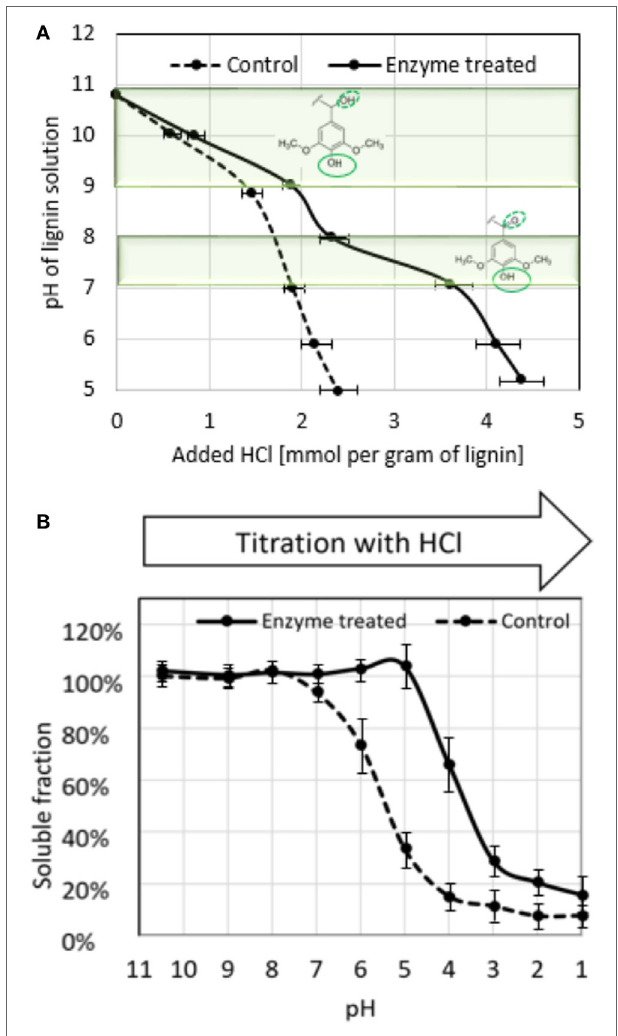
FigUre 3 | Properties of enzyme-treated lignin revealed from acid titration. (a) Acid titration curve of enzyme-treated and control lignin; highlighted areas indicate pH ranges of deprotonation of phenolic hydroxyls (pH 9–11) and phenolic hydroxyls of lignin units with keto group at alpha-carbon (see Discussion), deprotonating hydroxyls in the molecules are outlined with solid line, substituent at alpha-carbon is outlined with dotted line; (B) solubility of enzyme-treated and control lignin at different pH. The results are average of three independent titrations.